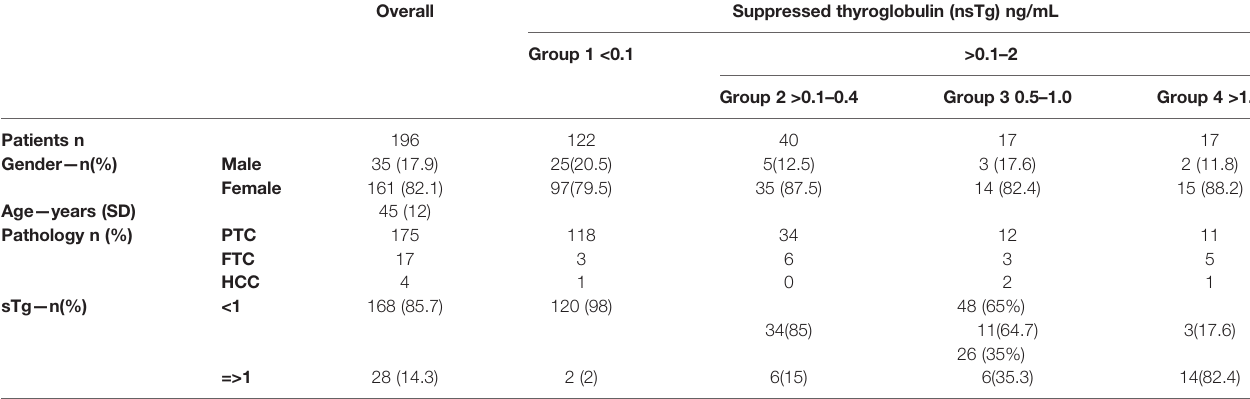
TABLE 1 | Baseline